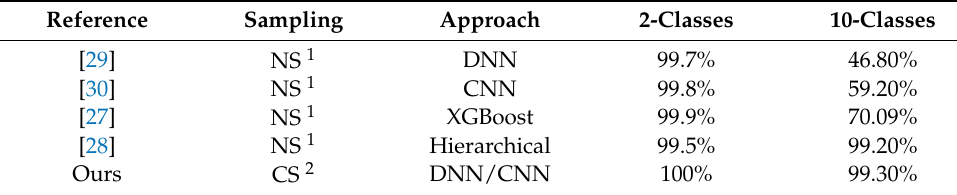
Table 5. Results of different sampling methods and machine